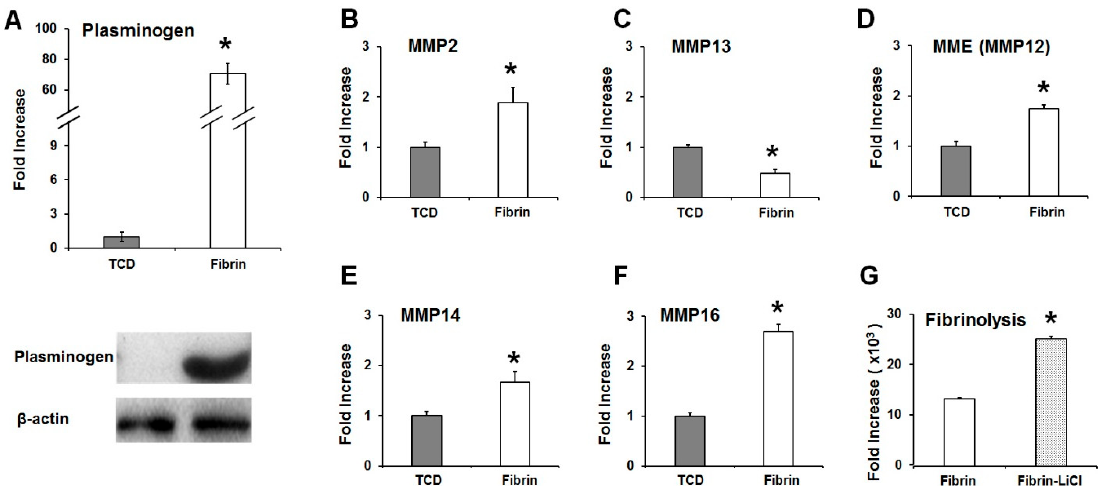
Figure 3. The OCCM30 on fibrin-enhanced expression of plasminogen. OCCM30-fibrin had a significantly higher expression level of plasminogen than that of the OCCM30-TCD ( A ) as well as fibrinolytic elements like matrix metalloproteinases (MMPs) ( B – F ). Moreover, LiCl treatment for the activation of canonical Wnt signaling as a positive control can lead to a fibrinolytic process in the OCCM30-fibrin like OCCM30-fibrin without the LiCl treatment even though there was a statistically significant difference ( G ). Each experiment was repeated two times independently. * Significantly different ( p < 0.05).